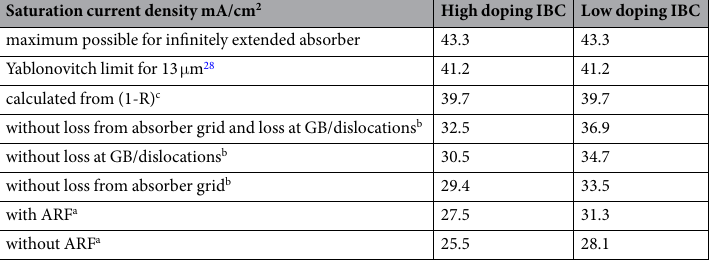
Table 2. Current analysis of best highly and lowly doped IBC cells (all in mA/cm 2 ). a Measured by solar simulator. b Calculated from LBIC measurements. c Measured by UV/VIS spectrometer. Rest: calculated from literature data.